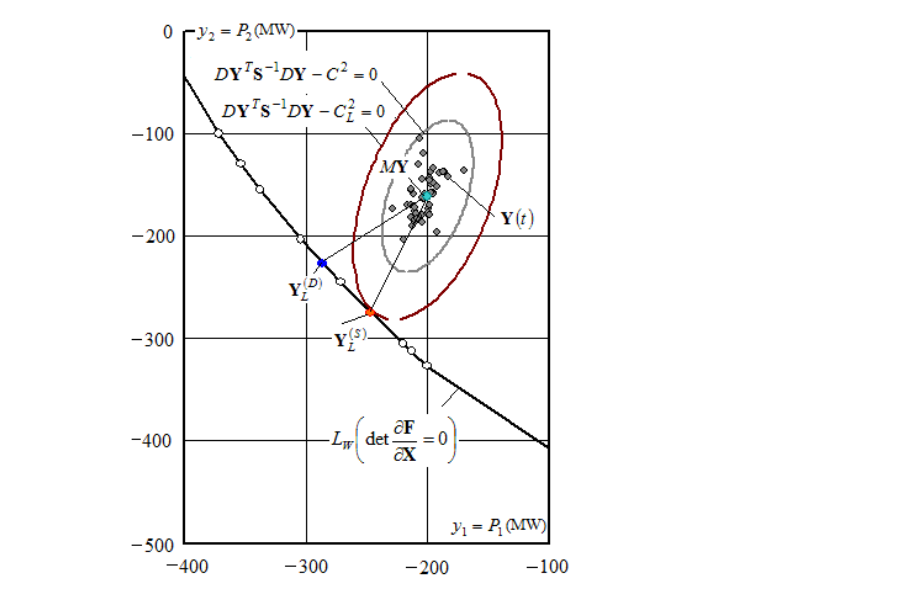
Figure 5. Results of determining limiting modes in a deterministic statement: y